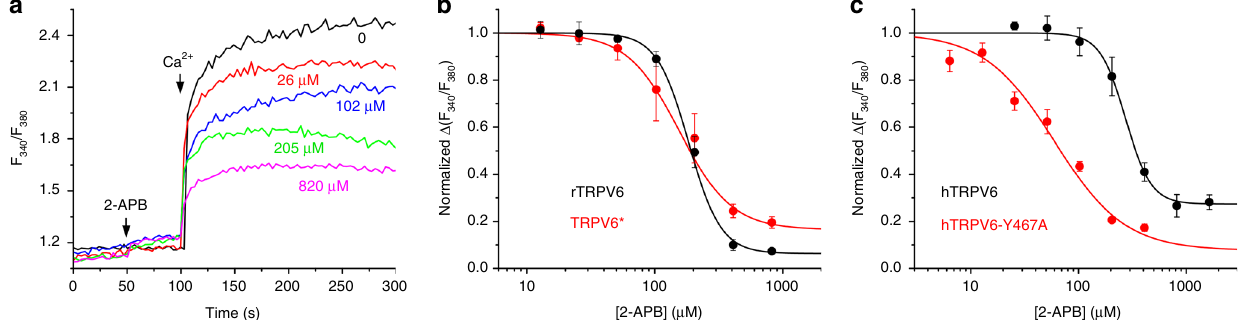
Fig. 1 2-APB inhibition of Ca 2 + uptake through wild-type and mutant TRPV6 channels. a Ratiometric Fura-2 fl uorescence curves recorded from HEK 293 cells expressing TRPV6* in response to application of 2 mM Ca 2 + after preincubation of cells in different concentrations of 2-APB. Arrows indicate the times when 2-APB and Ca 2 + were added. These experiments were repeated independently three times with similar results. b Dose – response curves for 2-APB inhibition of Ca 2 + uptake calculated for wild-type rTRPV6 (black) and TRPV6* (red) ( n = 3 for all measurements). The changes in the fl uorescence intensity ratio at 340 and 380 nm ( F 340 / F 380 ) evoked by addition of 2 mM Ca 2 + after preincubation with various concentrations of 2-APB were normalized to the maximal change in F 340 / F 380 after addition of 2 mM Ca 2 + in the absence of 2-APB. Straight lines through the data points are fi ts with the logistic equation, with the mean ± SEM values of the half-maximum inhibitory concentration (IC 50 ), 184 ± 8 and 156 ± 20 μ M, and the maximal inhibition, 93.6 ± 1.1% and 83.5 ± 2.9%, for rTRPV6 and TRPV6*, respectively. c Dose – response curves for 2-APB inhibition of Ca 2 + uptake calculated for wild-type hTRPV6 (black) and hTRPV6-Y467A (red) ( n = 3 for all measurements) are fi ts with the logistic equation, with the parameter values IC 50 = 274 ± 27 and 60 ± 13 μ M, and the maximal inhibition, 72.6 ± 2.7% and 92.4 ± 8.1%, for hTRPV6 and hTRPV6-Y467A, respectively. The leftward shift of the 2-APB dose – response curve of hTRPV6-Y467A, when compared to the dose – response curve of wild-type hTRPV6, indicates an increased af fi nity of the channel for 2-APB. Error bars represent